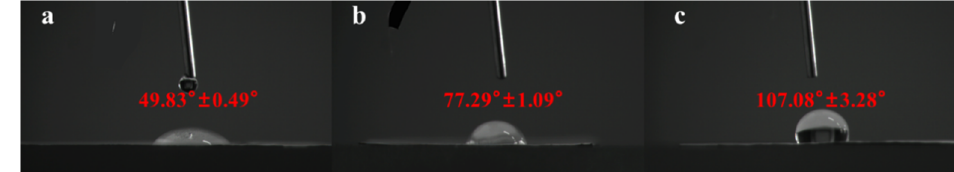
Figure 4. The contact angle (CA) measurement of ART ‐ loaded PCL/Col nanofibers with different polymer ratios: ( a ) PCL/Col ‐ A; ( b ) PCL/Col ‐ B; ( c ) PCL/Col ‐ C. polymer ratios: ( a ) PCL/Col-A; ( b ) PCL/Col-B; ( c ) PCL/Col-C.